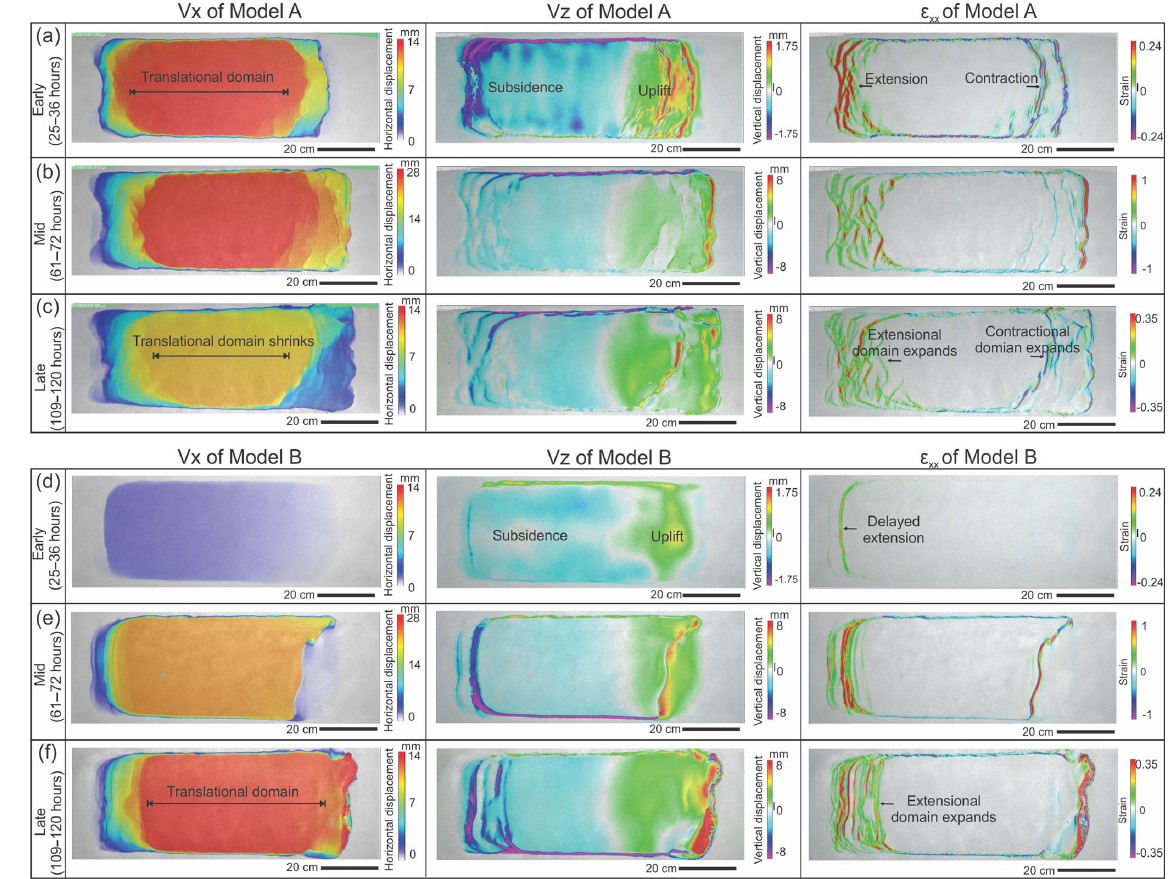
Figure 4. ( a – c ) Map view of incremental horizontal and vertical displacement ( V x , V z ) and strain pattern ( ε xx ) derived from 3-D DIC strain data of Model A from the (a) early (25–36h), (b) mid (61–72h) and (c) late stages (109–120h). Note the persistent translational domain throughout the experiment. ( d – f ) Map view of incremental horizontal and vertical displacement ( V x , V z ) and strain pattern ( ε xx ) of Model B from the (d) early (25–36h), (e) mid (61–72h) and (f) late stages (109–120h). Note the delayed deformation and large translational domain in the model. The horizontal displacement ( V x ) displays downslope displacement of the sedimentary cover (left to right in map view). The vertical displacement ( V z ) displays total subsidence and uplift. The horizontal strain ( ε xx ) shows location of the extensional (red) and contractional (purple)